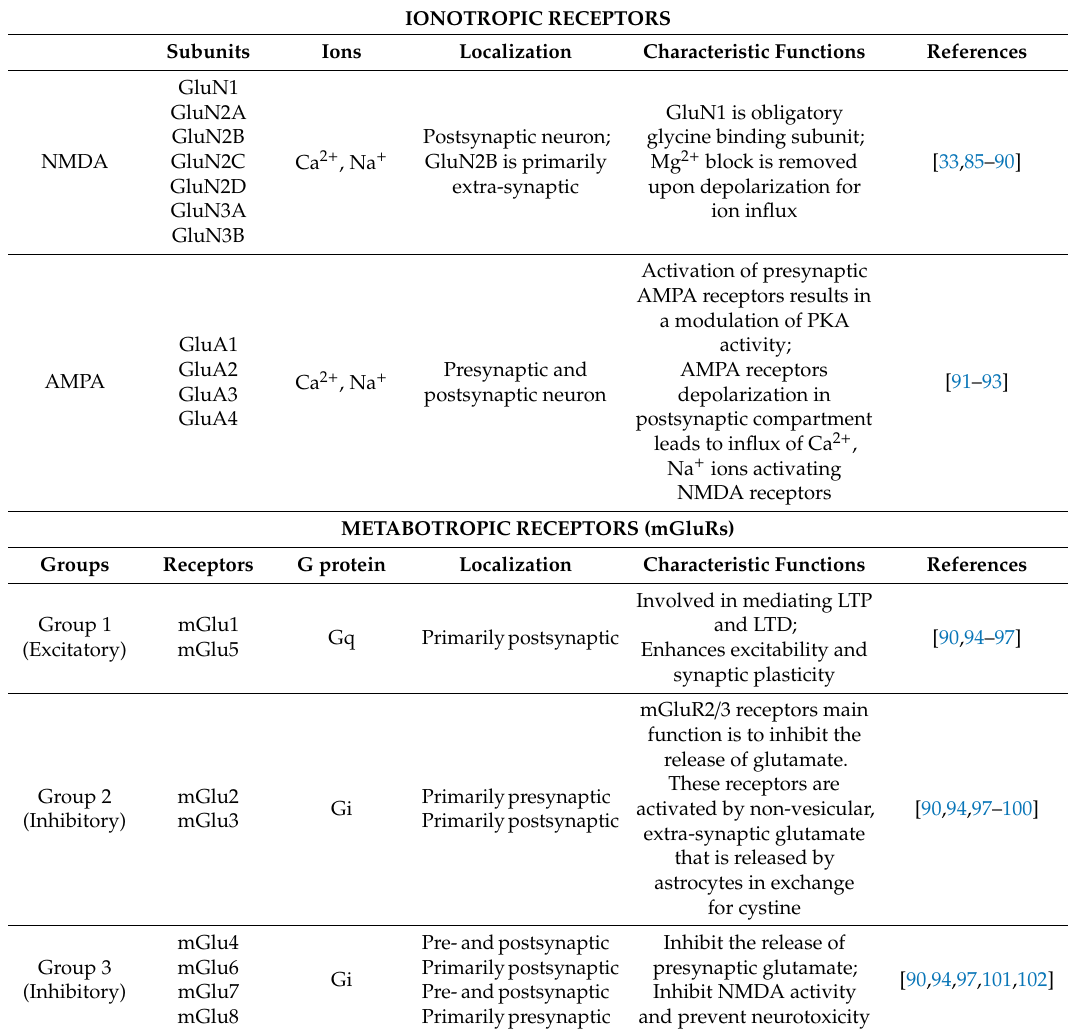
Table 1. Overviewofglutamatergicreceptorsmanlyinvolvedinthepathophysiologyandpharmacotherapy of